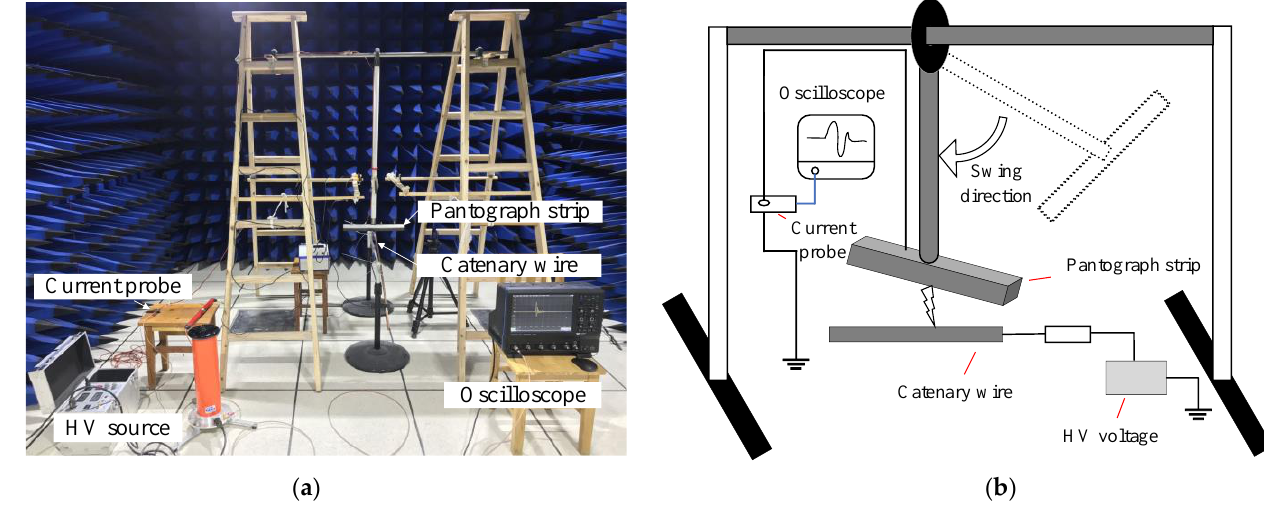
Figure 1. Overall layout of the experiment: ( a ) experiment photo; ( b ) simplified schematic.